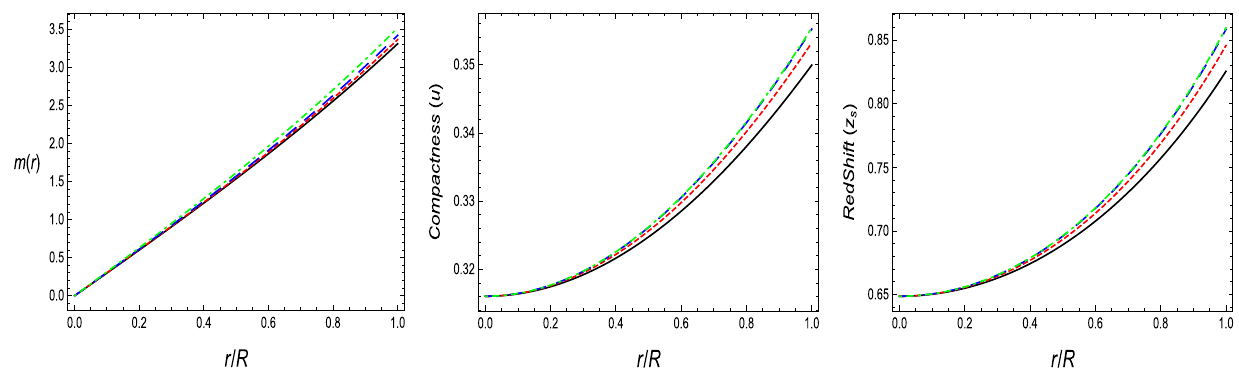
Fig. 5 Profiles of mass function ( m ( r ) ), compactness ( u ) and redshift ( z s ) versus radial coordinate, r . The same set of numerical values has been used to plot these graphs as mentioned in Fig.2